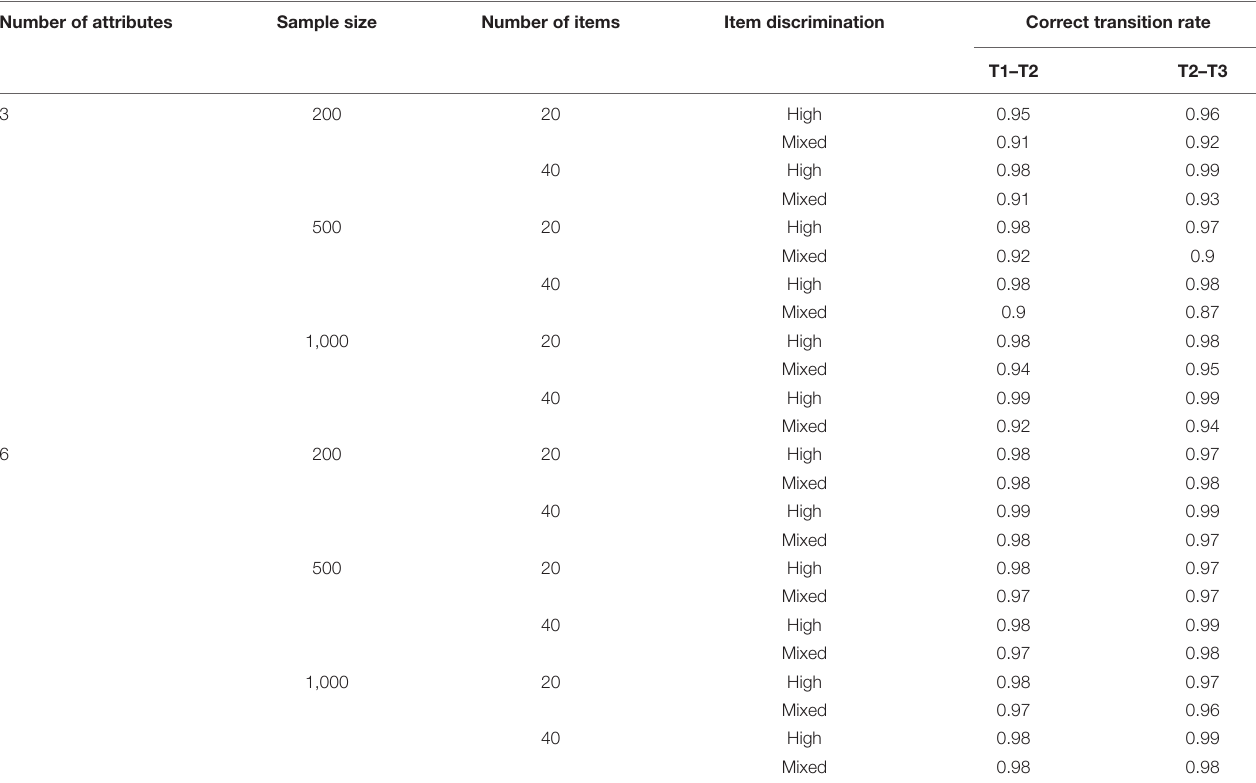
TABLE 6 | Correct transition rate of attribute master